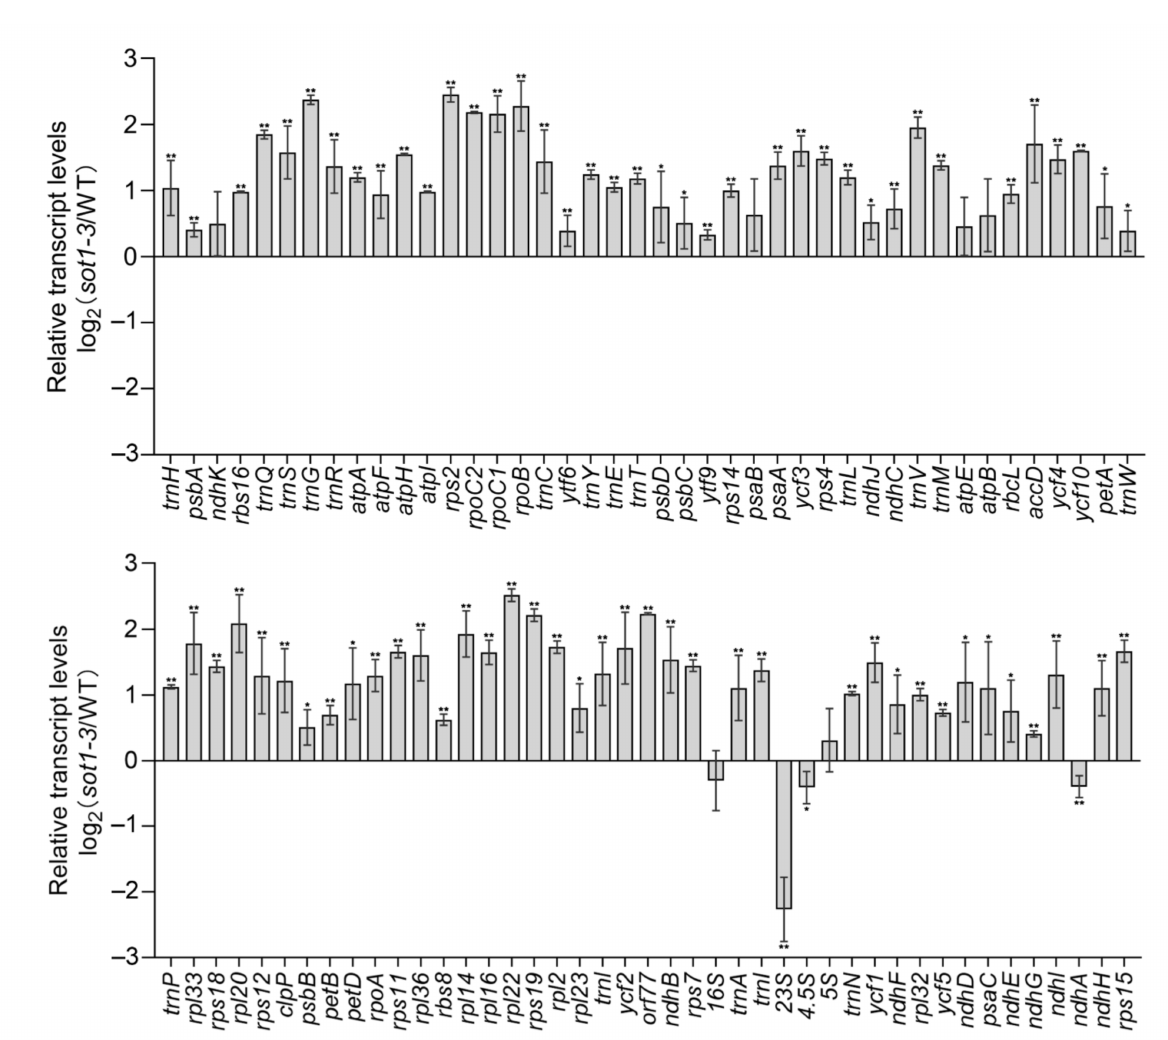
Figure 1. Steady-state levels of chloroplast gene transcripts in the wild type (WT) and sot1-3 . The transcript levels of the chloroplast genes were determined using quantitative PCR (qPCR) in 12-day-old seedlings. The values are given as log2 fold changes of gene expression in the sot1-3 mutant relative to that of the WT. Mean values ± SD of three independent experiments are shown. Student’s t -test was carried out to determine the significance of the difference of transcript levels between WT and sot1-3 plants. * indicates a significant difference at p < 0.05, whereas ** indicates a significant difference at p <